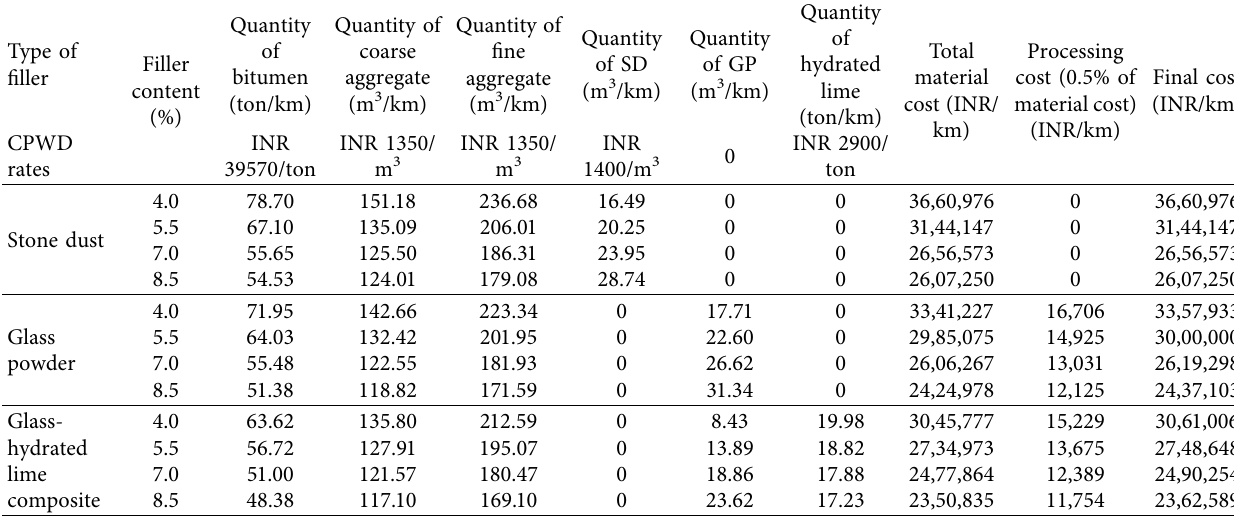
Table 7: Cost analysis of various